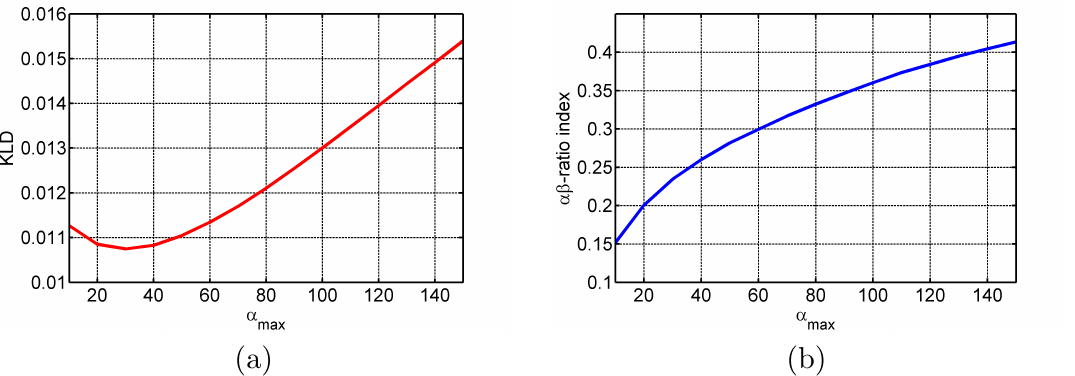
Figure 10. Houston test case. Evolution of: ( a ) the KLD parameter and ( b ) αβ -ratio index, as a function of the α max variation for the EWF technique.